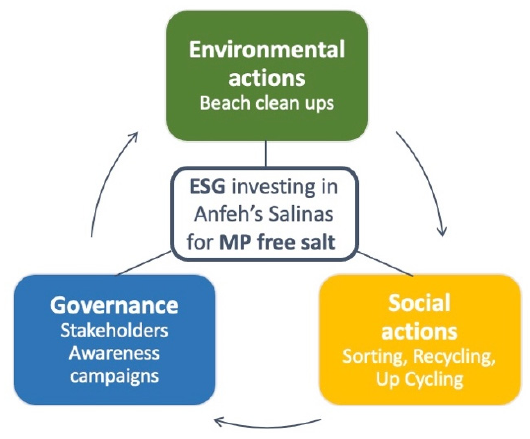
Figure 1. Proposed Conceptual